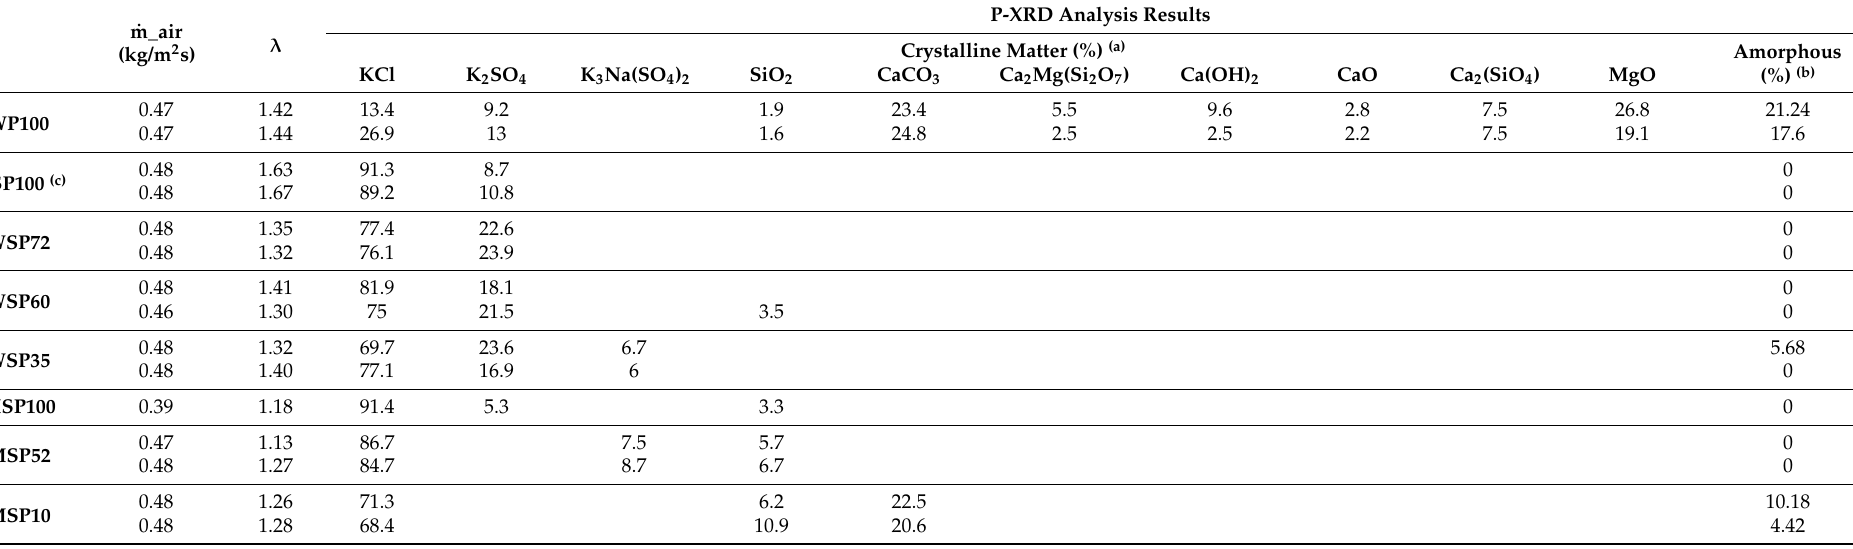
Table 7. Deposits composition (combustion test